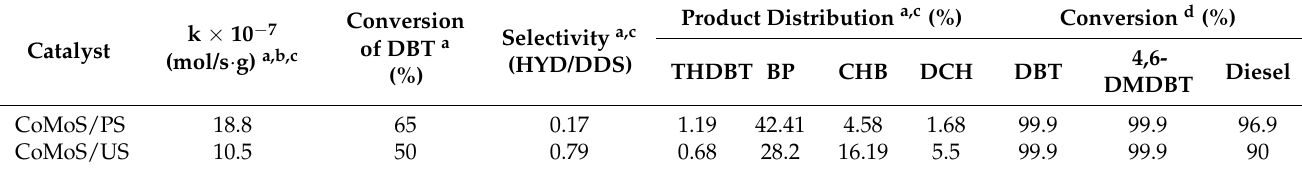
Table 4. DBT, 4,6-DMDBT and diesel HDS reaction conversion over CoMoS